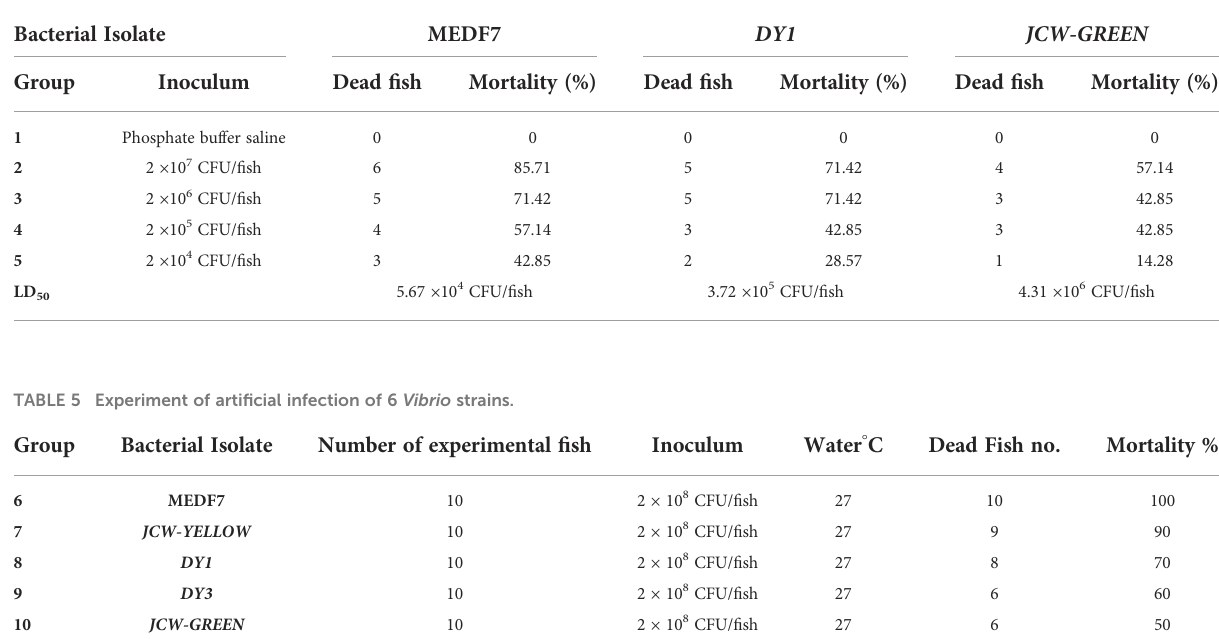
TABLE 4 The LD 50 of 3 strains of Vibrio .